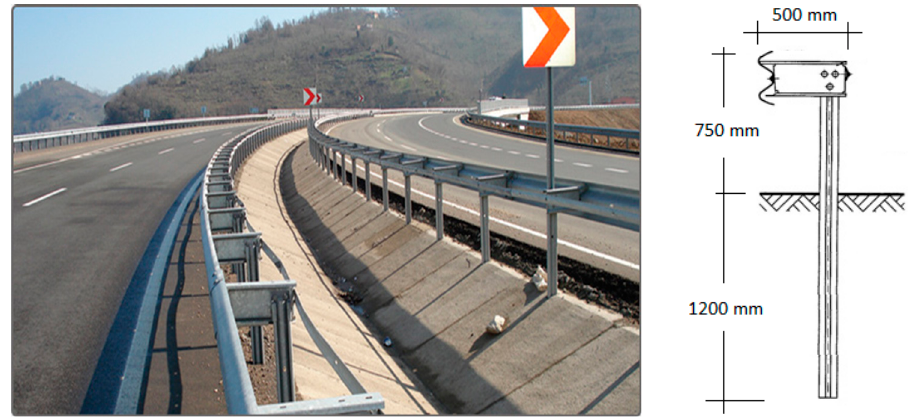
Figure 5. Dimensions and installed view of a steel barrier EDSP-1.33.